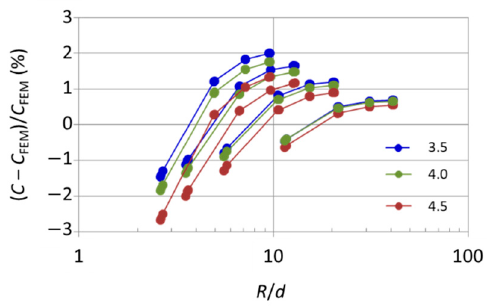
Figure A1. Relative differences ( C − C FEM )/ C FEM (in %) in function of R / d ratio at three ε r values (3.5, 4, and 4.5) for MC2 Technologie samples. Error bars corresponding to the uncertainty of 0.1% for C FEM values are too small to be represented.